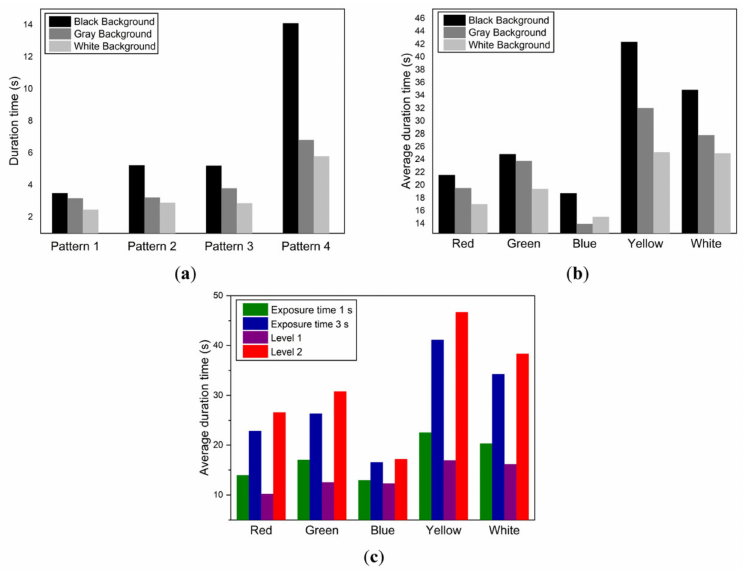
Figure 6. Duration of afterimage. ( a ) Positive afterimage in different backgrounds; ( b ) Duration in different backgrounds; ( c ) Duration with different exposure times and luminance